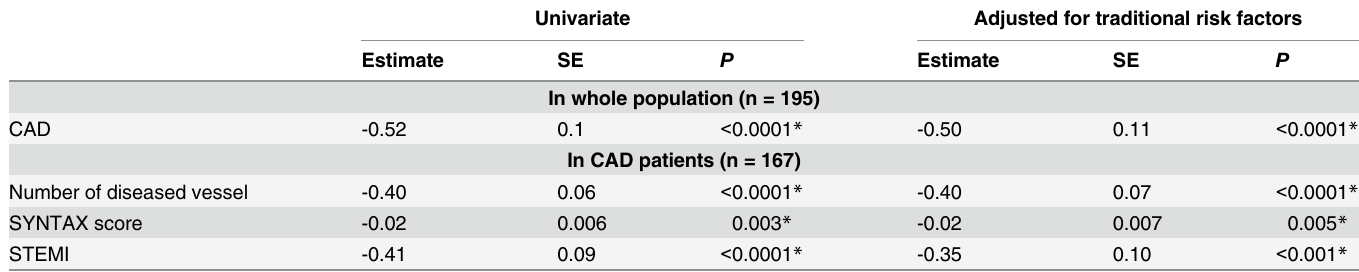
Table 3. Association of miRNA-145 with severity of